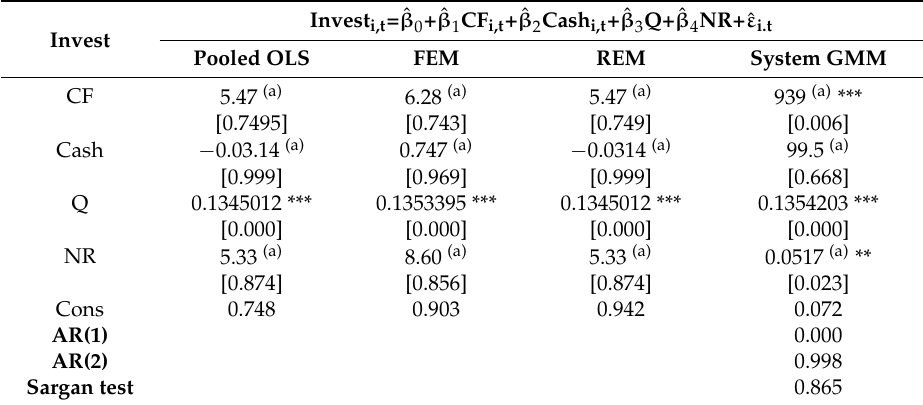
Table 5. Regression results on the impact of internal cash flow on investment (Model